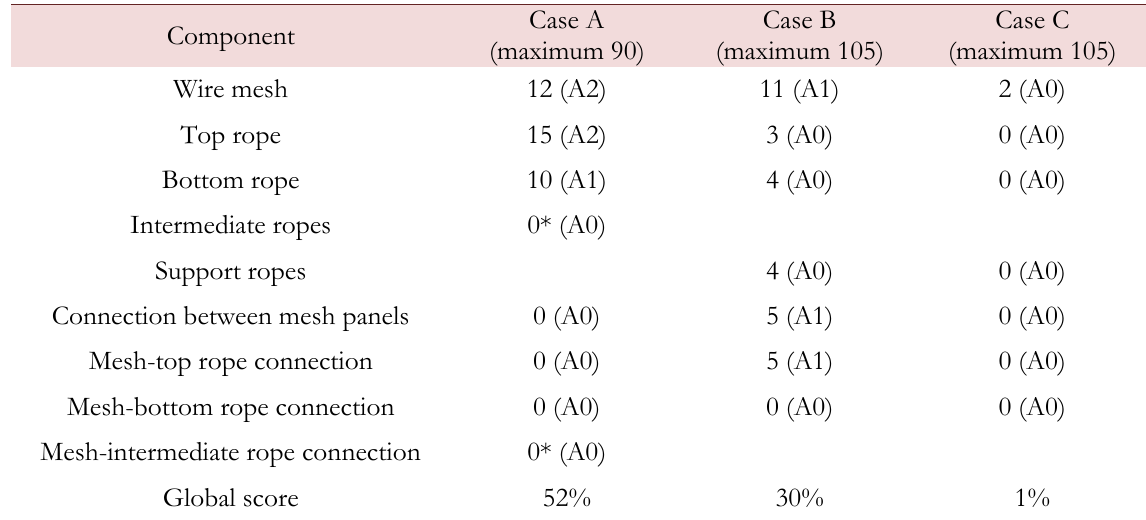
Table 7: Results of the survey campaign on the three cases commented in the text. The sum of the scores and the most severe maintenance level (in round brackets) are reported for each component. If the component is not present, a sign * is added to the